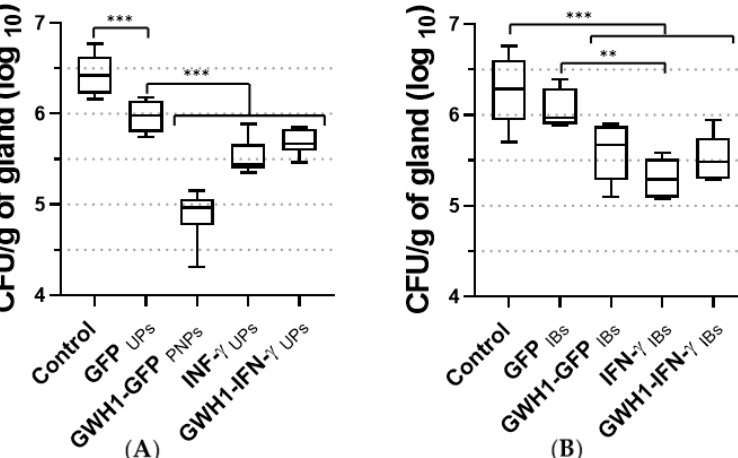
Figure 6. Bacterial loads ( E. coli CFU / g of gland log10) measured after the administration of therapeutic and non-therapeutic protein formats into infected mammary glands. ( A ) E ff ect of unassembled protein forms (UPs) and assembled protein-only nanoparticles (PNPs) 8 h after the challenge with 100 CFU of E. coli . ( B ) E ff ect of the inclusion body (IB) format 8 h after the challenge with 100 CFU of E. coli . In all cases, 60 µ M of the di ff erent protein formats were administered just after the infection with E. coli . Sodium bicarbonate bu ff er (166 mmol / L NaHCO 3 , 333 mmol / L NaCl) and GFP were used as controls. The middle bars indicate median values for each group of glands (at least 6 glands) whereas the boxes specify quartiles Q1-Q3. Experiments were performed with at least three independent replicates. Significant results are shown as ** p ≤ 0.01 and *** p ≤ 0.001, one-way analysis of variance (ANOVA) followed by Tukey’s multiple comparisons